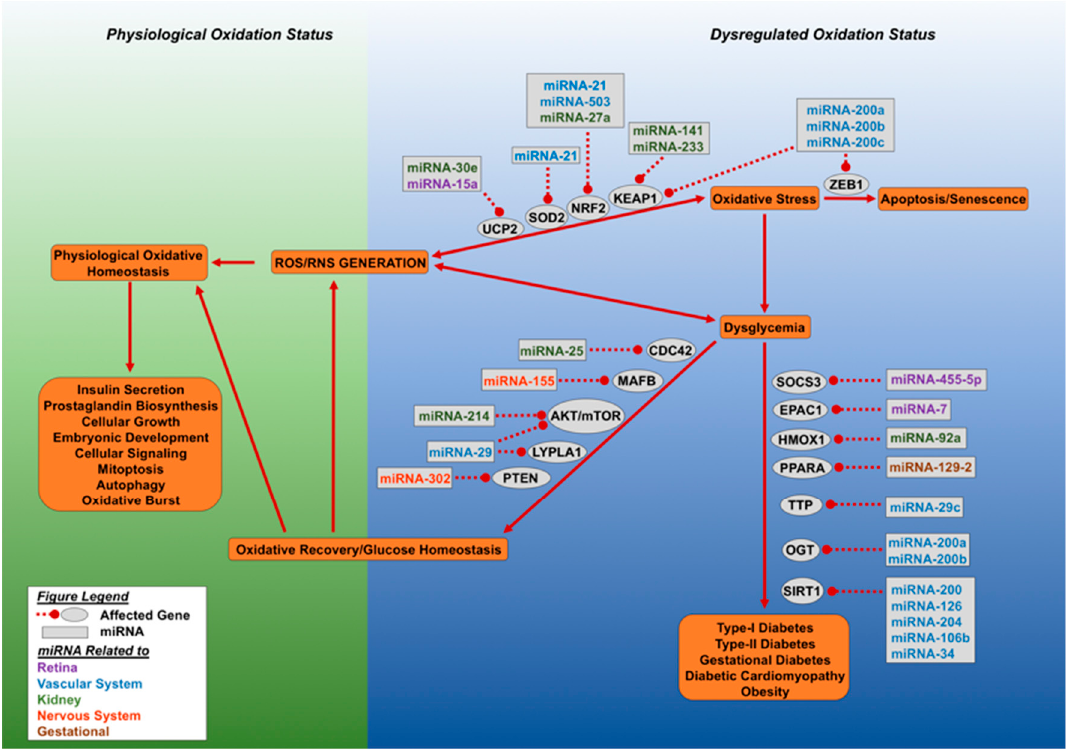
Figure 2. Dysregulated oxidative stress and microRNAs result in loss of glucose homeostasis. This figure outlines the effect of aberrant accumulation of cellular reactive oxygen species (ROS) and reactive nitrogen species (RNS). Cellular oxidative status is maintained by SOD2, NRF2, and UCP2, which allows for a spectrum of physiological functions carried out by the cell. Excessive ROS and RNS generation led to dysglycemia or cellular senescence. The miRNA molecules can target NRF2 (miRNA-21, miRNA-27a, miRNA-503, miRNA-233), SOD2 (miRNA-21), and UCP2 (miR-30e and miR-15a), leading to loss of oxidative regulation and the initiation of oxidative stress. Cellular oxidative stress can lead to either dysglycemia or cellular senescence. Cellular senescence is mediated by the inhibition of zinc finger E-box binding homeobox 1 (ZEB1) by miR-200 family miRNAs. Dysglycemia develops when O-linked β -N-acetylglucosamine transferase (OGT) and NAD-dependent deacetylase sirtuin-1 (SIRT1) are targeted by specific miRNAs. Oxidative stress driven dysglycemia rapidly initiates the expression of miRNA molecules which target suppressor of cytokine signaling 3 (SOCS3), exchange factor directly activated by cAMP 1 (EPAC1), and heme oxygenase (decycling) 1 (HMOX1), Peroxisome proliferator-activated receptor alpha (PPARA), mitochondrial uncoupling protein 2 (UCP2), and tristetraprolin (TTP), leading to decreased expression of these genes and the advance of diabetes. Alternatively, recovery can occur by miRNA directed targeting of genes involved in dysglycemia, they include: Cell division control protein 42 homolog (CDC42), V-maf musculoaponeurotic fibrosarcoma oncogene homolog B (MAFB), protein kinase B and mammalian target of rapamycin (AKT/mTOR), acyl-protein thioesterase 1 (LYPLA1) and phosphatase and tensin homolog (PTEN). Recovery of glucose homeostasis results in oxidative normalization and cellular homeostasis. Different colors of miRNA denote affected organ.